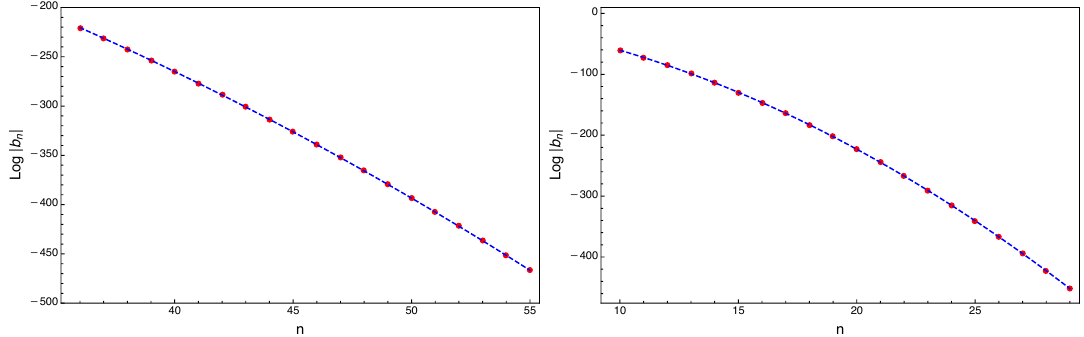
from the asymptotic result (4.11), n |